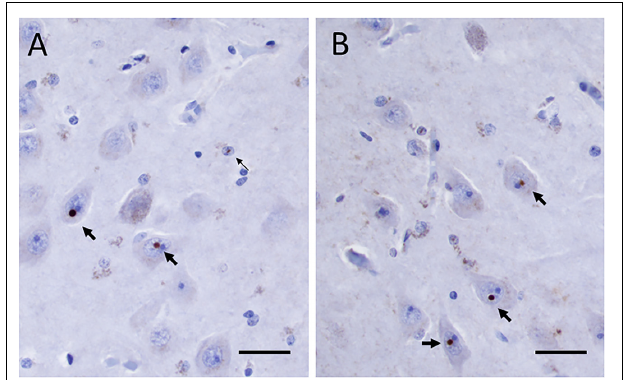
FIGURE 3 | (A,B) FMRpolyG positive inclusions in neurons (thick arrows) and in astrocyte-like cell (thin arrow in panel A ) in the CA4 region of the hippocampus. Scale bars: 25 µ